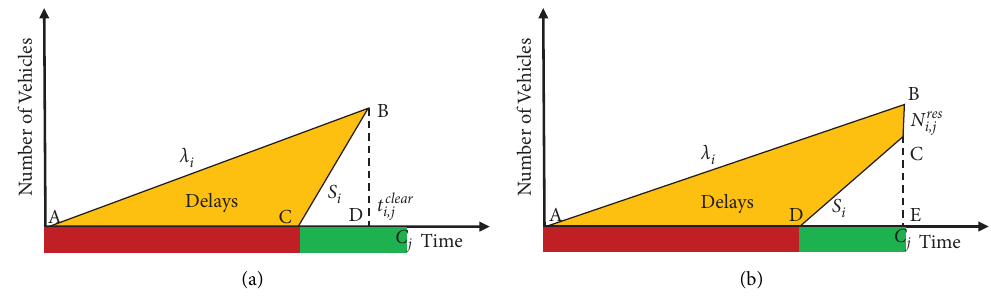
Figure 5: Diagram of state “queue cleared.” (a) End without vehicle left. (b) End with vehicles not cleared.